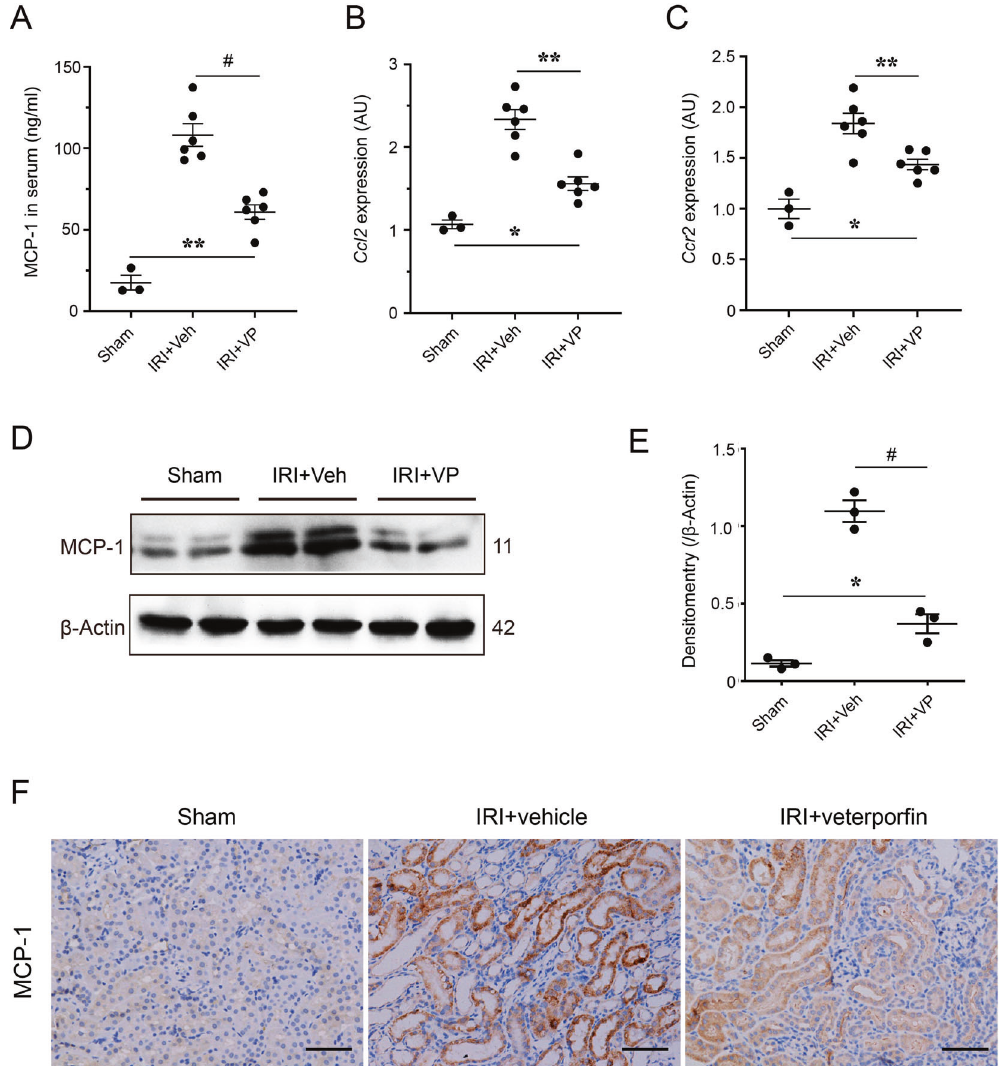
Fig. 5 The impact of pharmacological inhibition of YAP on increased renal MCP-1 after AKI. A Serum levels of MCP-1 in Sham, IRI + Veh, and IRI + VP mice ( n = 3 for Sham and n = 6, 6 for IRI + Veh and IRI + VP, respectively). B Renal mRNA levels of Ccl2 and C Ccr2 in Sham, IRI + Veh, and IRI + VP mice ( n = 3 for sham and n = 6, 6 for IRI + Veh and IRI + VP, respectively). AU arbitrary units. D Expression of renal MCP-1 in Sham, IRI + Veh, and IRI + VP mice. Shown are representative blots from at least three separate experiments with similar results. E Quanti fi cation and analysis of MCP-1 expression. F Representative images of immunohistochemistry staining for renal MCP-1 in Sham, IRI + Veh, and IRI + VP mice. Scale bar = 50 µm in all images of F . All values are means ± SEM. * p < 0.05, ** p < 0.01, and # p < 0.001 de fi ned as signi fi